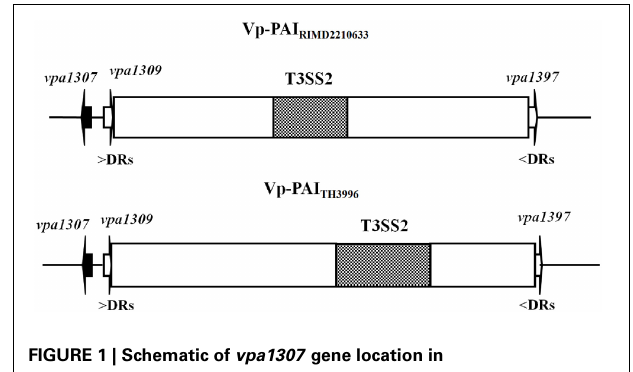
FIGURE 1 | Schematic of vpa1307 gene location in V. parahaemolyticus RIMD2210633 and TH3996. Vp-PAI (open box) is flanked by direct repeats (DRs, 5 (cid:3) -AACTC-3 (cid:3) ). The white arrows ( vpa1309 and vpa1397 ) indicate the first and last genes outside the VP-PAI. The vpa1307 gene and T3SS2 gene cluster are also